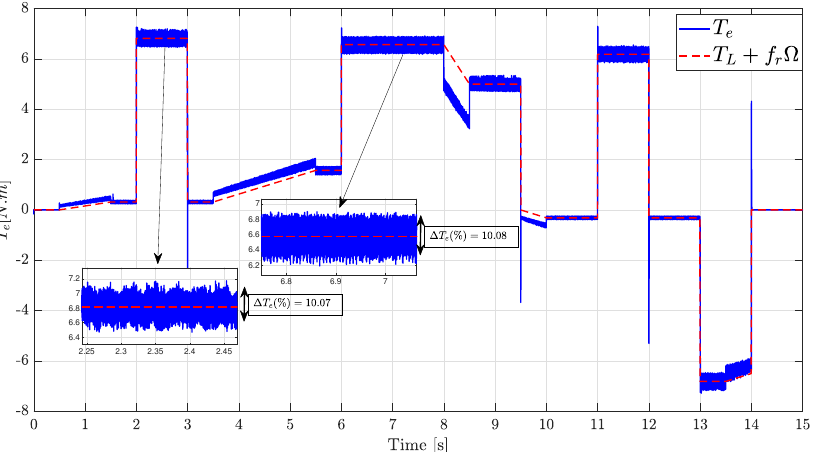
Figure 17. Torque response obtained by SMC controllers and optimal currents calculations